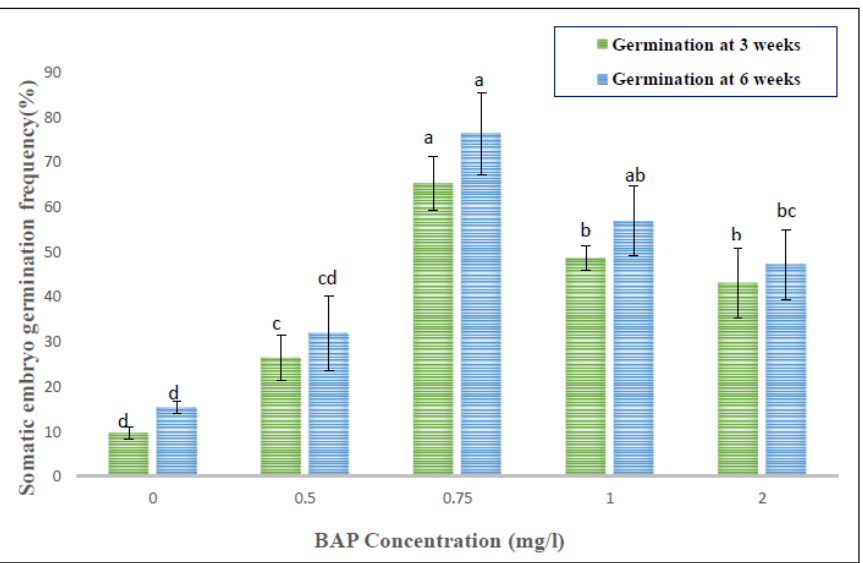
Figure 4. Effect of BAP-fortified MS medium on somatic embryo germination after a three- and six-week period, respectively. Values indicate the Mean ± SE of three replicates per treatment. Mean values with different superscripts within a column are significantly different from each other as per DMRT at p ≤ 0.05.